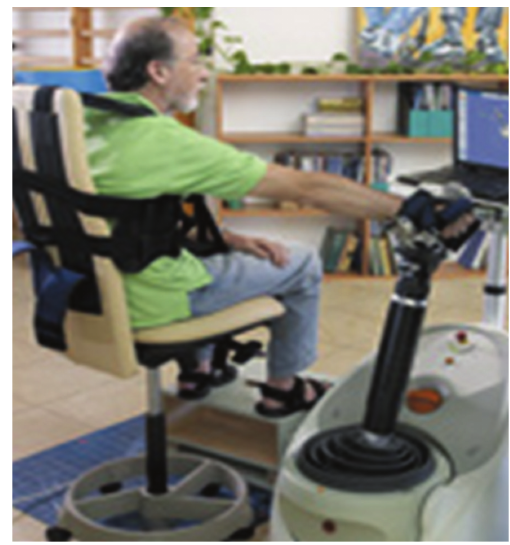
Figure 2: REO therapy training device (with trunk strap